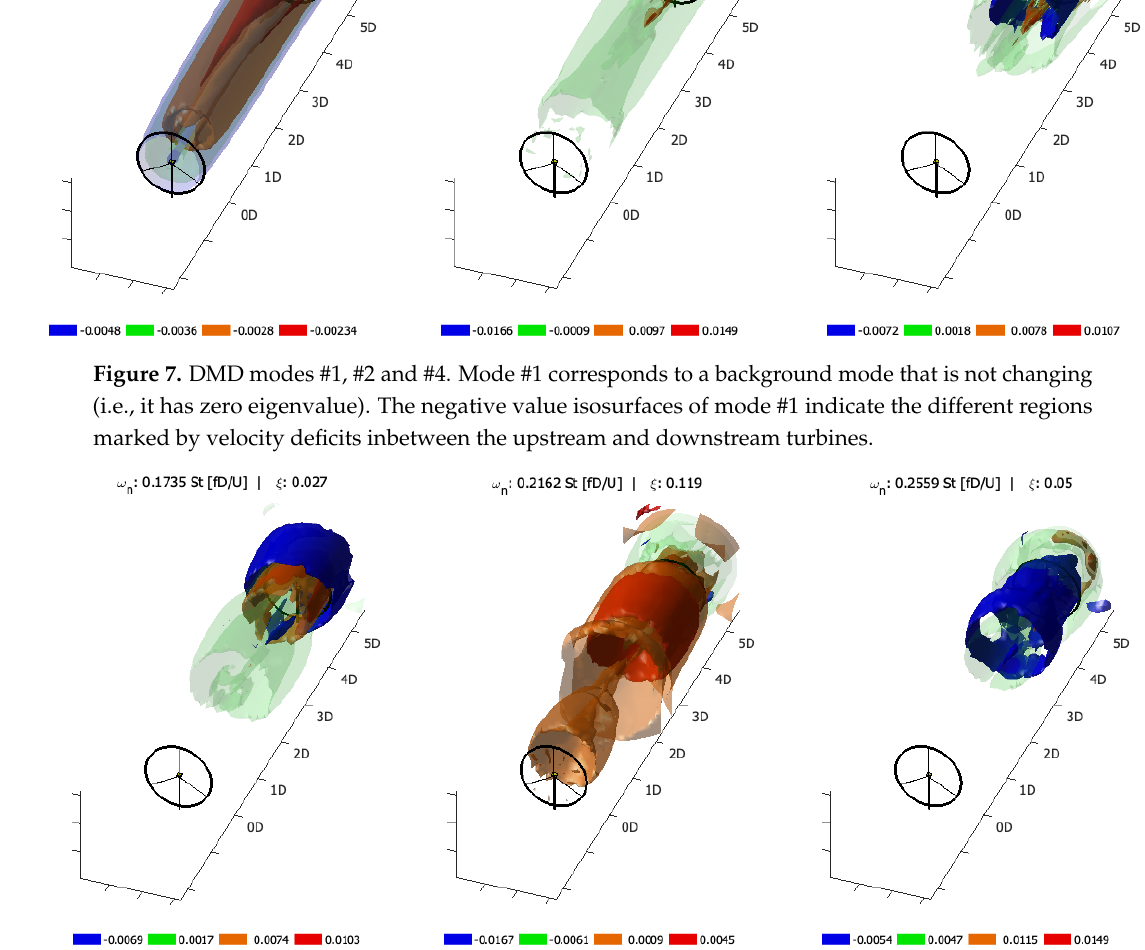
Figure 8. DMD modes #6, #7 and #8, with natural frequencies comprised between 0.17 St and 0.26 St